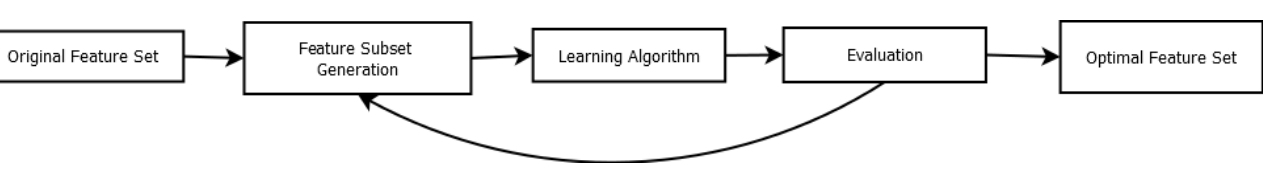
Figure 8. Existing sequential model of feature selection.